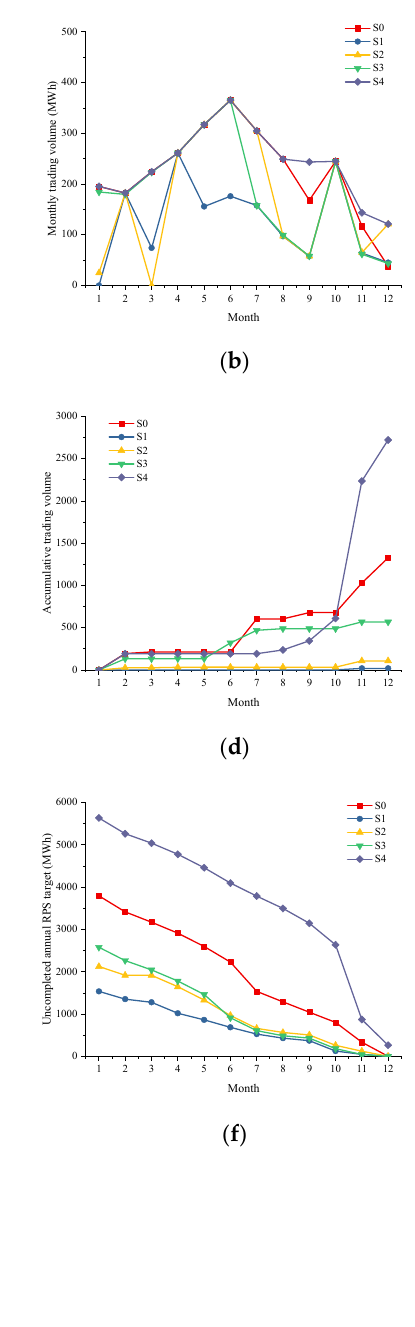
Figure 8a,b show trends of accumulative trading volume and monthly trading vol- ume of renewable power.